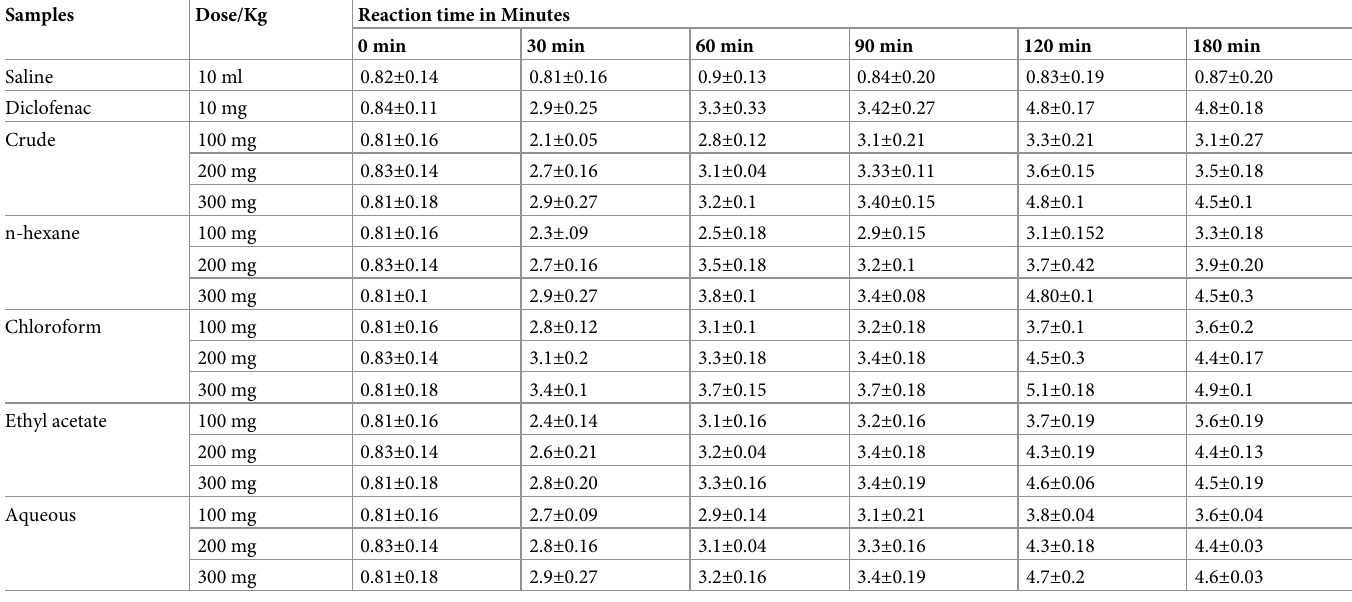
Table 6. Effect of Iris albicans crude and its corresponding fractions on tail-immersion test in mice.